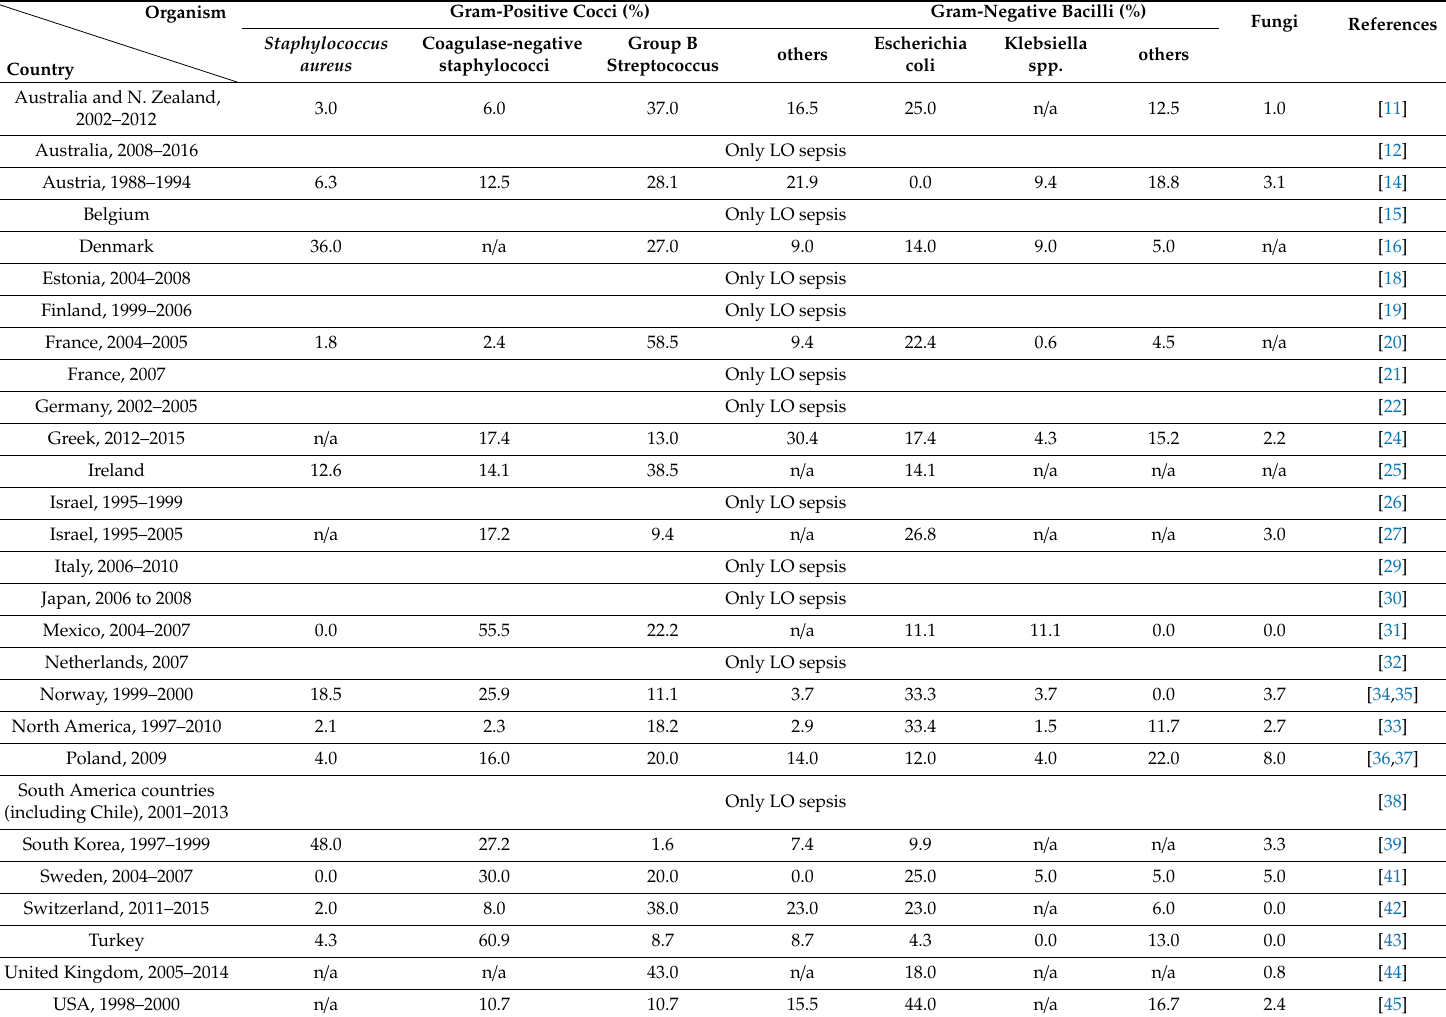
Table 4. Share of the most common species of Gram-positive cocci, Gram-negative bacilli, and fungi in early-onset neonatal sepsis (in alphabetical order).